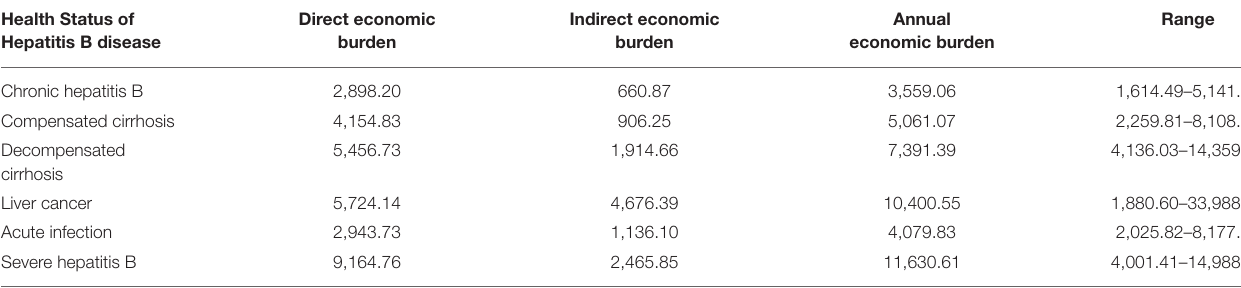
TABLE 5 | Burden of hepatitis B disease and related diseases (in USD).